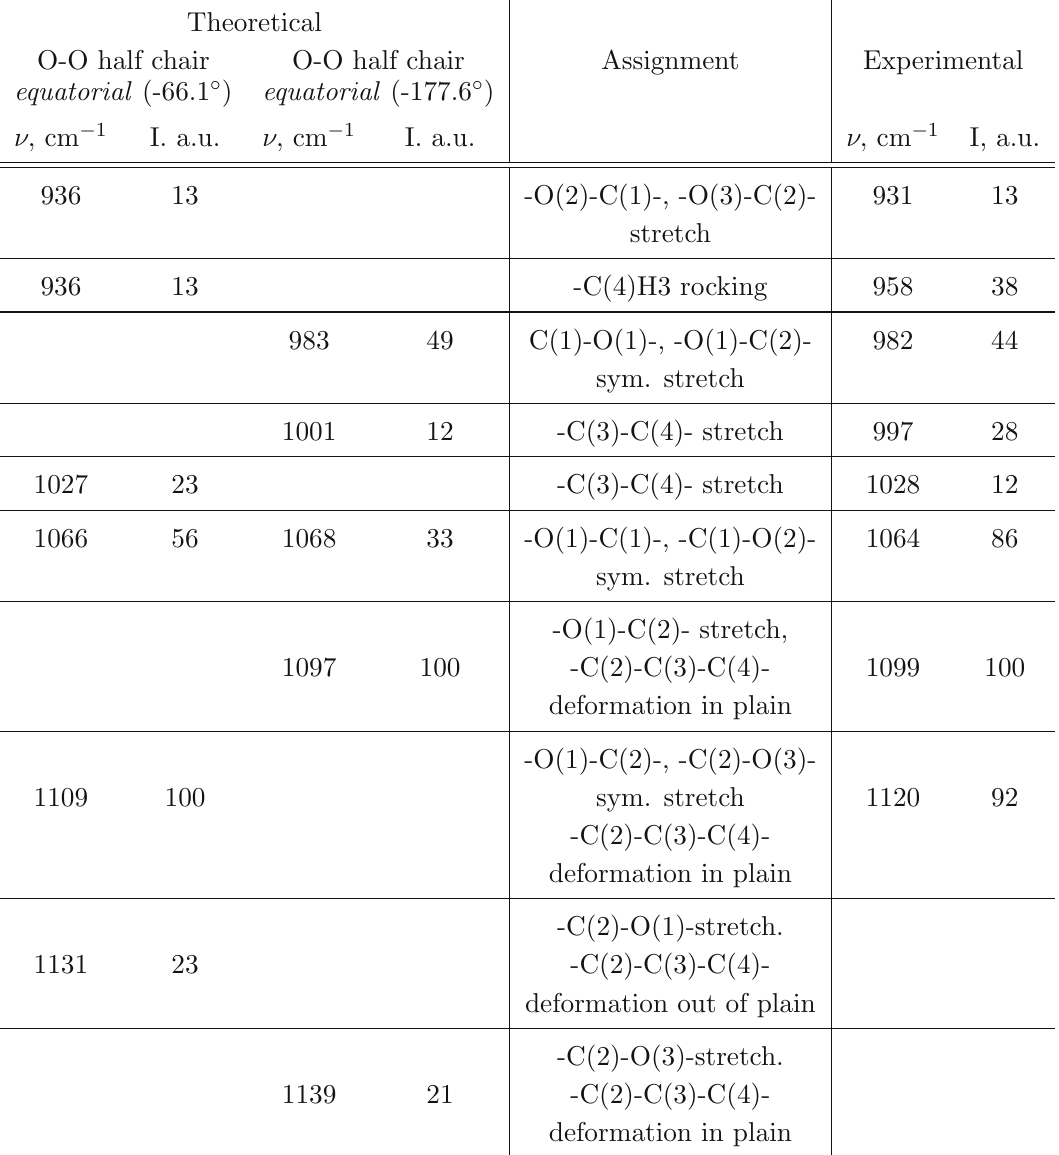
“a.u.” means arbitrary